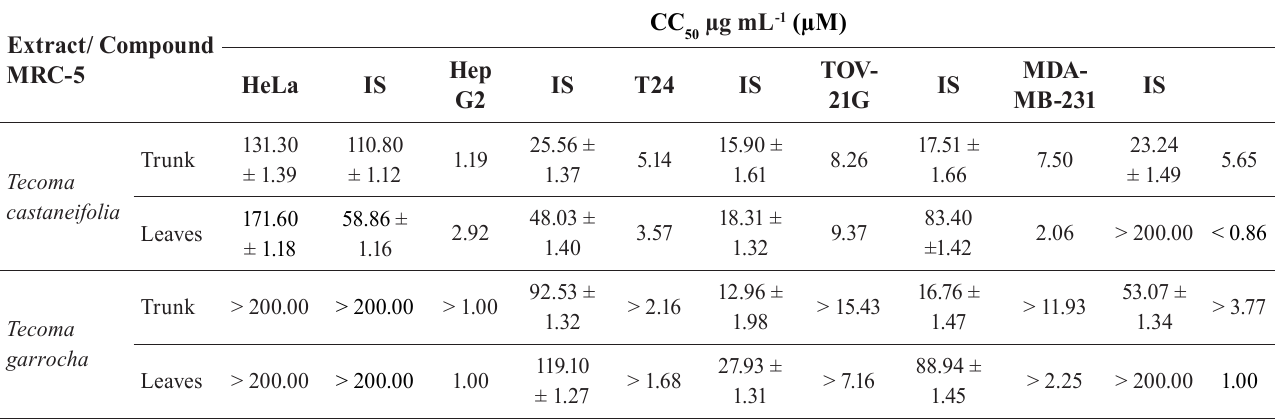
) of Tecoma species extract and lignans 50